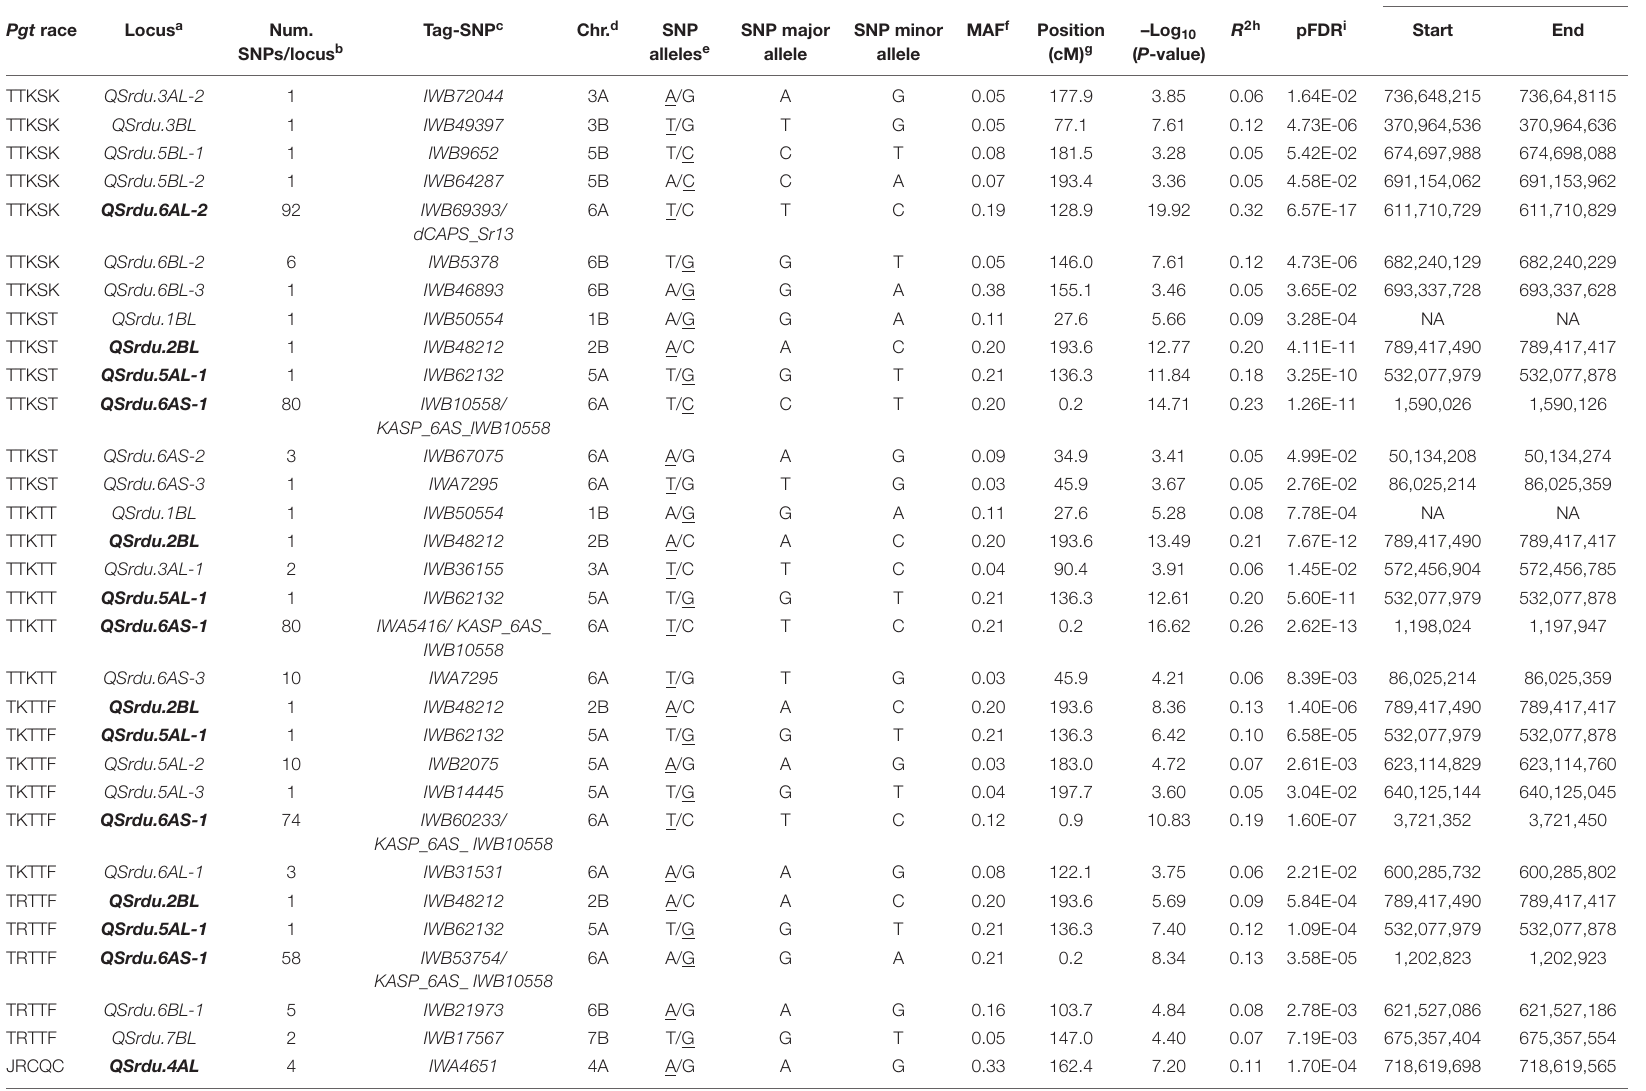
TABLE 4 | Summary of stem rust resistance loci in the durum wheat